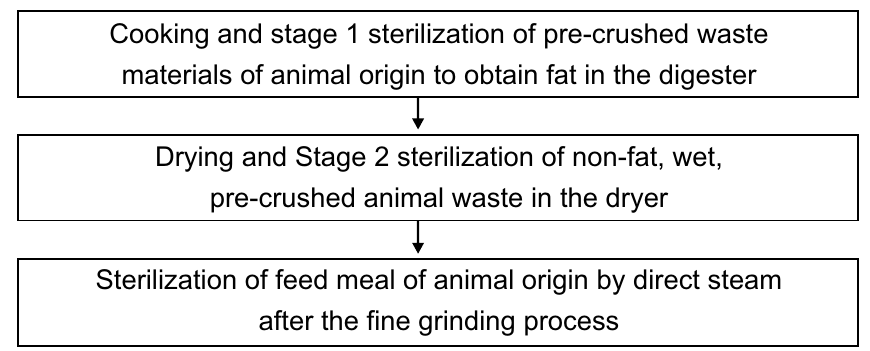
Fig. 2. Diagram of the technology of multi-stage sterilization of animal